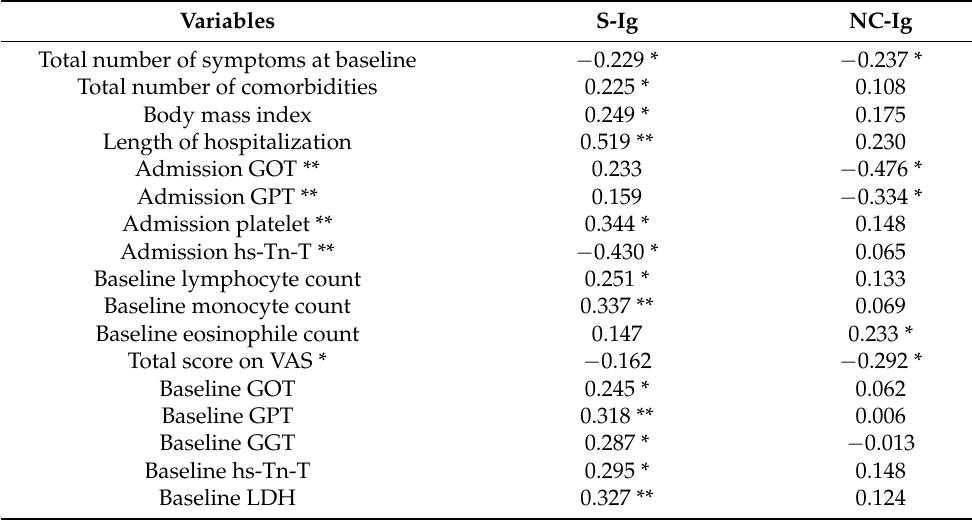
Table 3. Cross-sectional analysis among SARS-CoV-2 antibodies and variables at